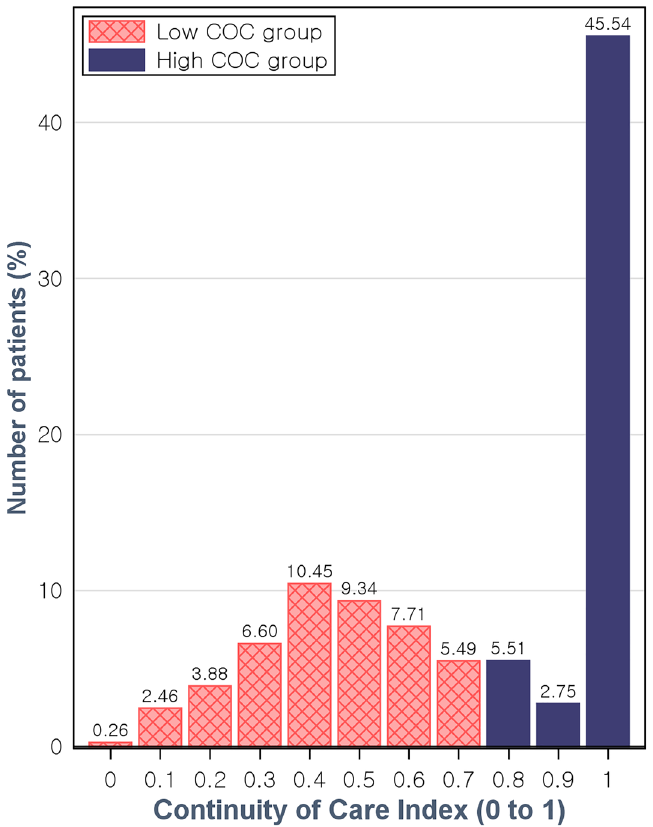
Figure 3. Continuity of Care Index distribution during the first 3 years. COC continuity of